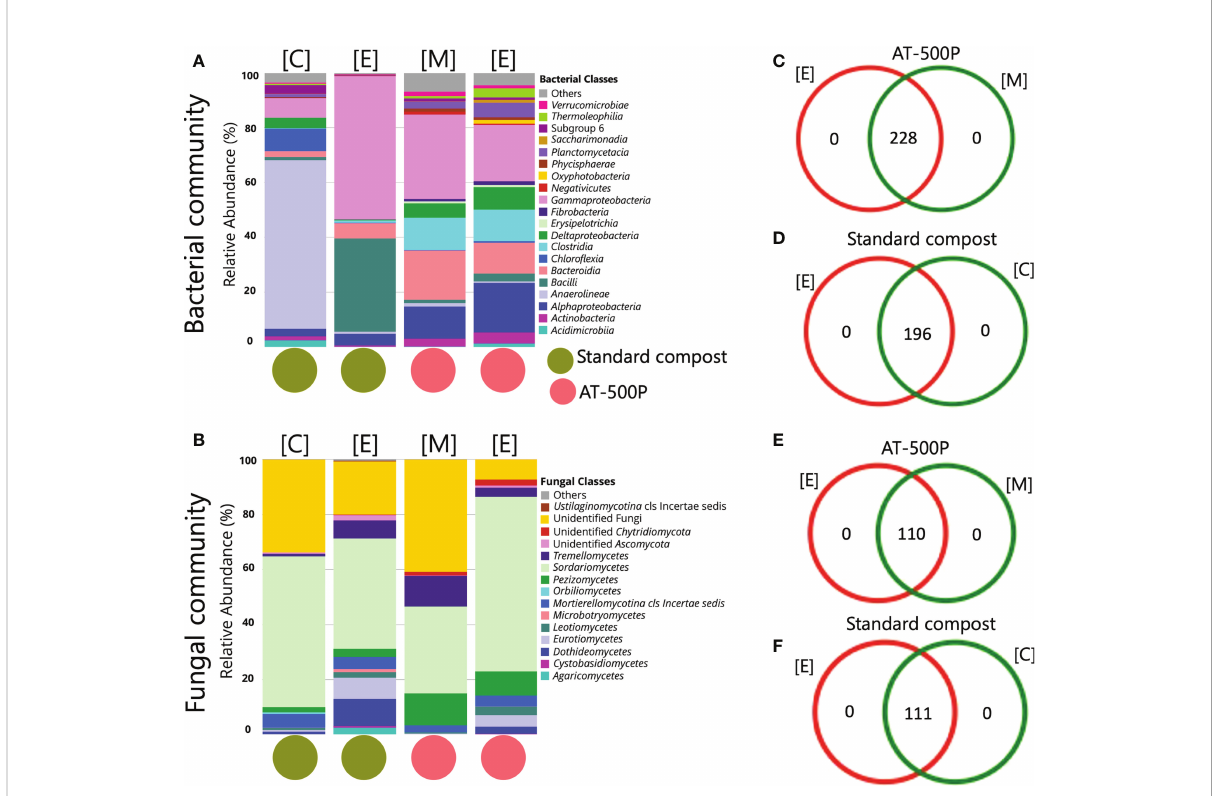
FIGURE 3 Comparison of microbial structure composition between AT-500P and standard compost as well as their respective extract. Panels (A, B) are stacked barplot representations of the bacterial and fungal community composition in precursors and extracts of compost and BD manure. Panels (C, D) are Venn diagrams representing the common bacterial ASVs shared between extract and precursor materials of compost and BD manure, while (E, F) represent the same for the fungal community. The acronyms [E], [C], and [M] represent extract, compost, and BD manure,